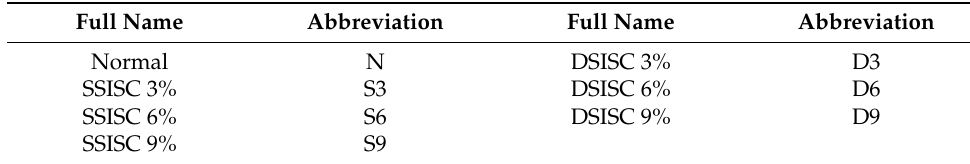
Table 3. Abbreviation of Different Cases.